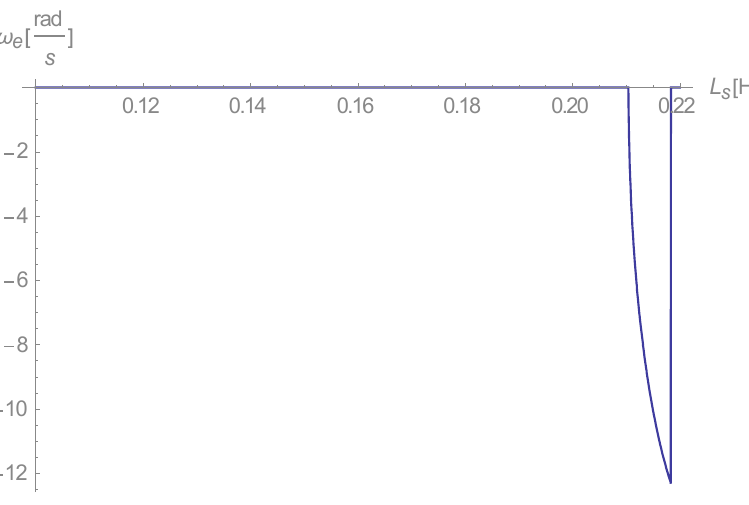
Figure 7. Plot of the imaginary part of the second solution of ω e (L S ).